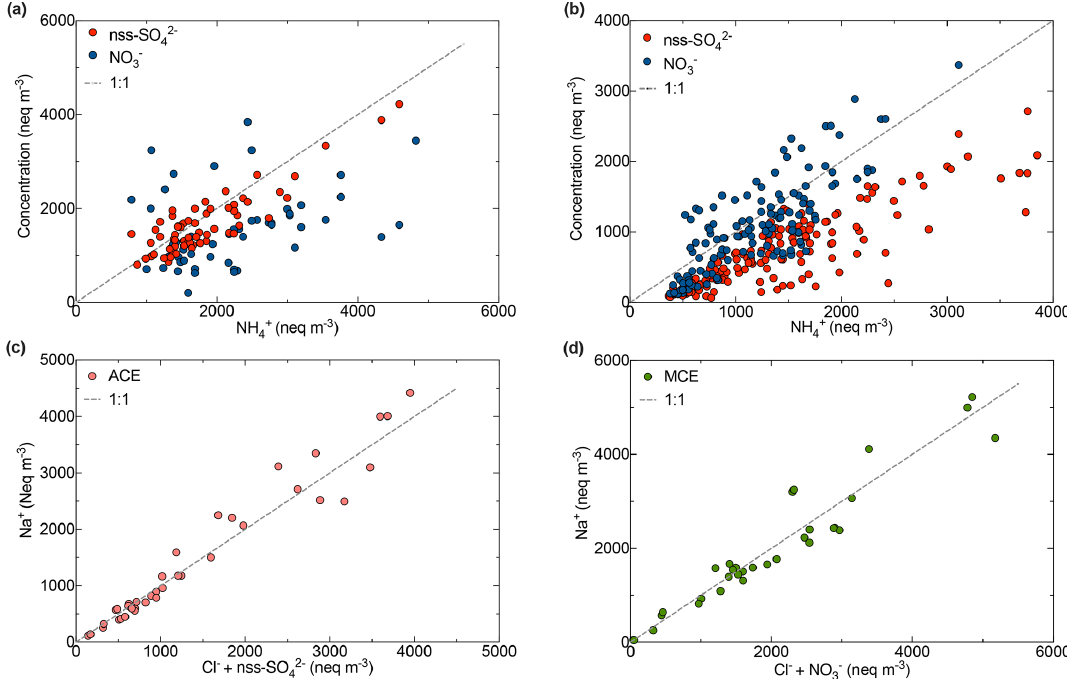
+ with NO − and nss-SO 2 − during summer; (b) NH + 4 3 4 for ACE air mass; (d) Na + and Cl − + NO − for MCE air mass at the AMV 4 3